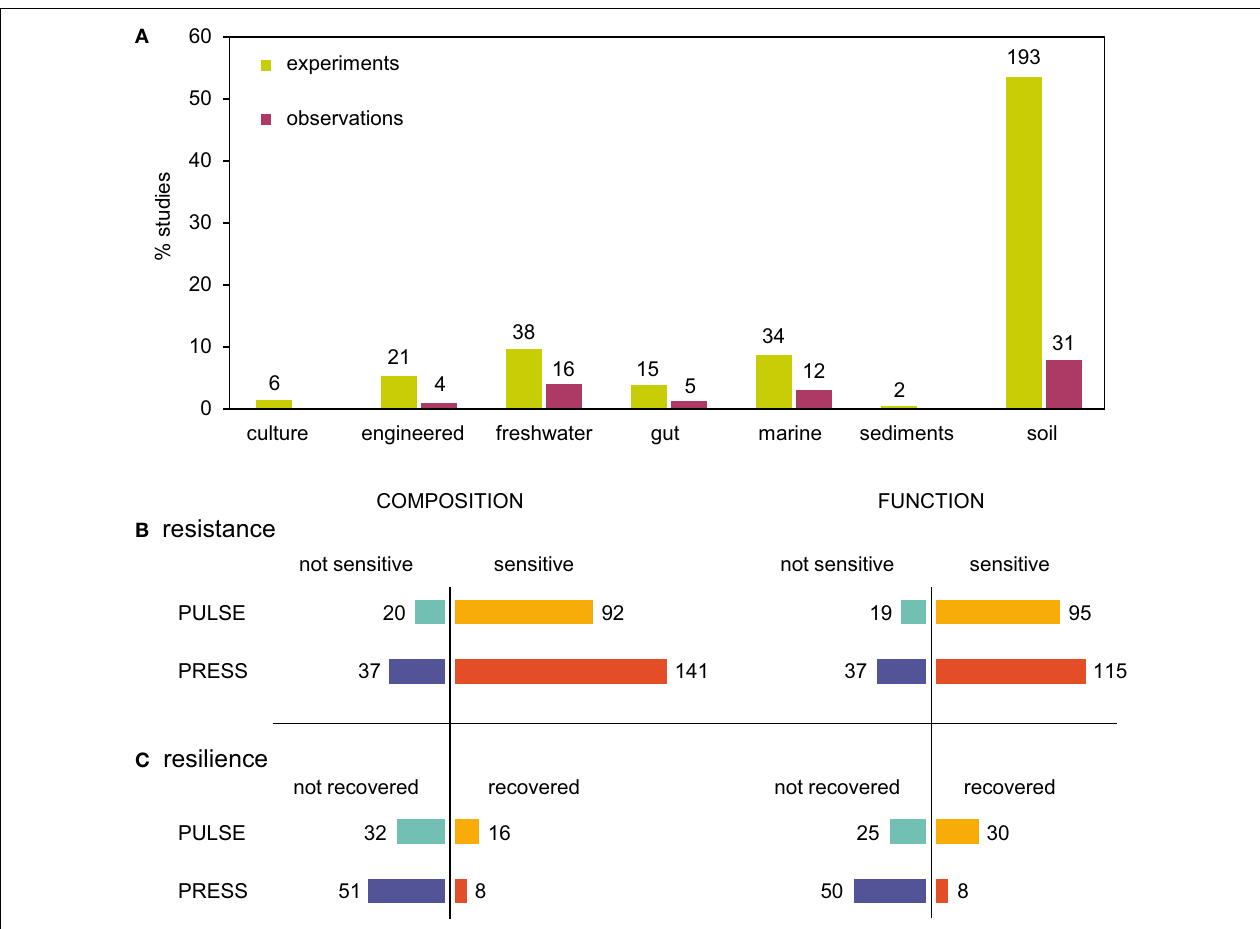
more than one disturbance or measured more than one function, and some studies did not report either. (B) Resistance was determined by sensitivity (change in composition or function after disturbance). Some investigations measured both composition and function, and were included in both charts. (C) If a community was sensitive to disturbance, resilience was measured as recovery to pre-disturbance composition or function. Many investigations that reported community sensitivity did not assess